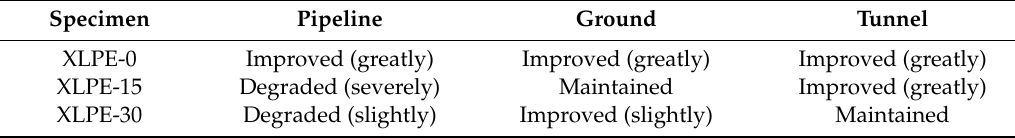
Table 8. Comprehensive assessment on the specimens under the thermal e ff